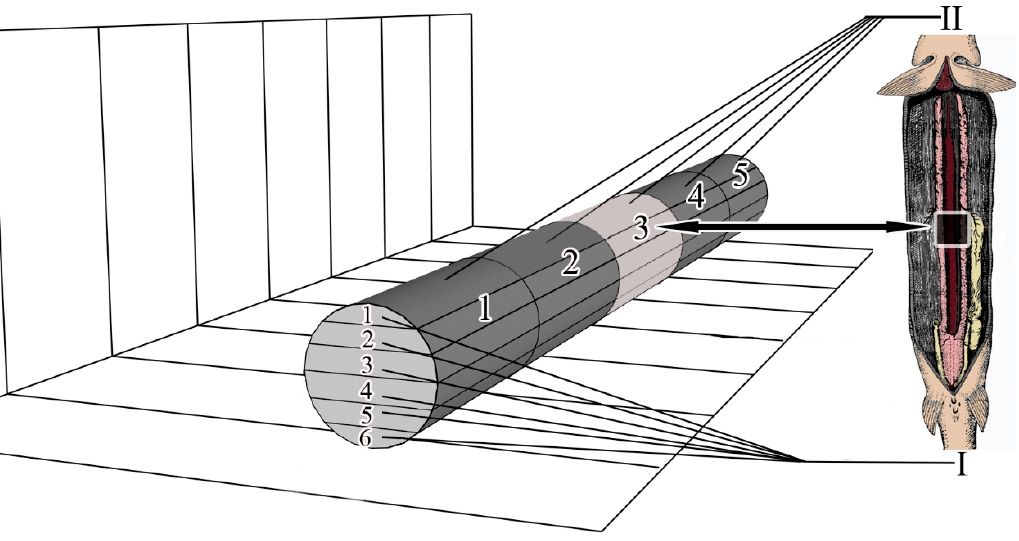
Figure 1. Scheme of axes and planes of the mesonephros. I—layers (1–6), II—segmental parts (1–5).